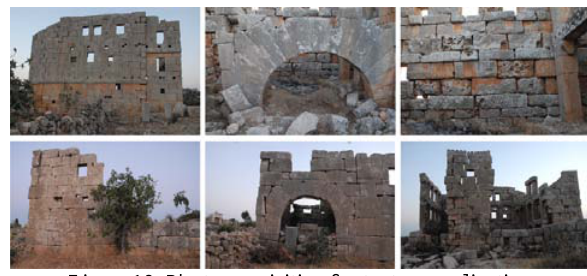
Figure 18. Photo acquisition for texture application.